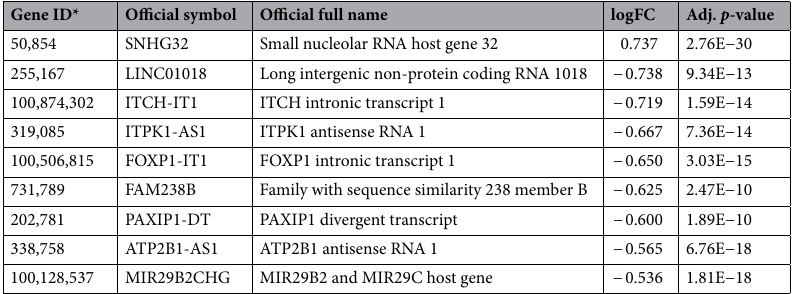
Table 1. Differentially expressed lncRNAs in colorectal cancer based on analyses of GSE106582 Dataset. Log2FC < 0: down-regulated, *From NCBI RefSeqGene.